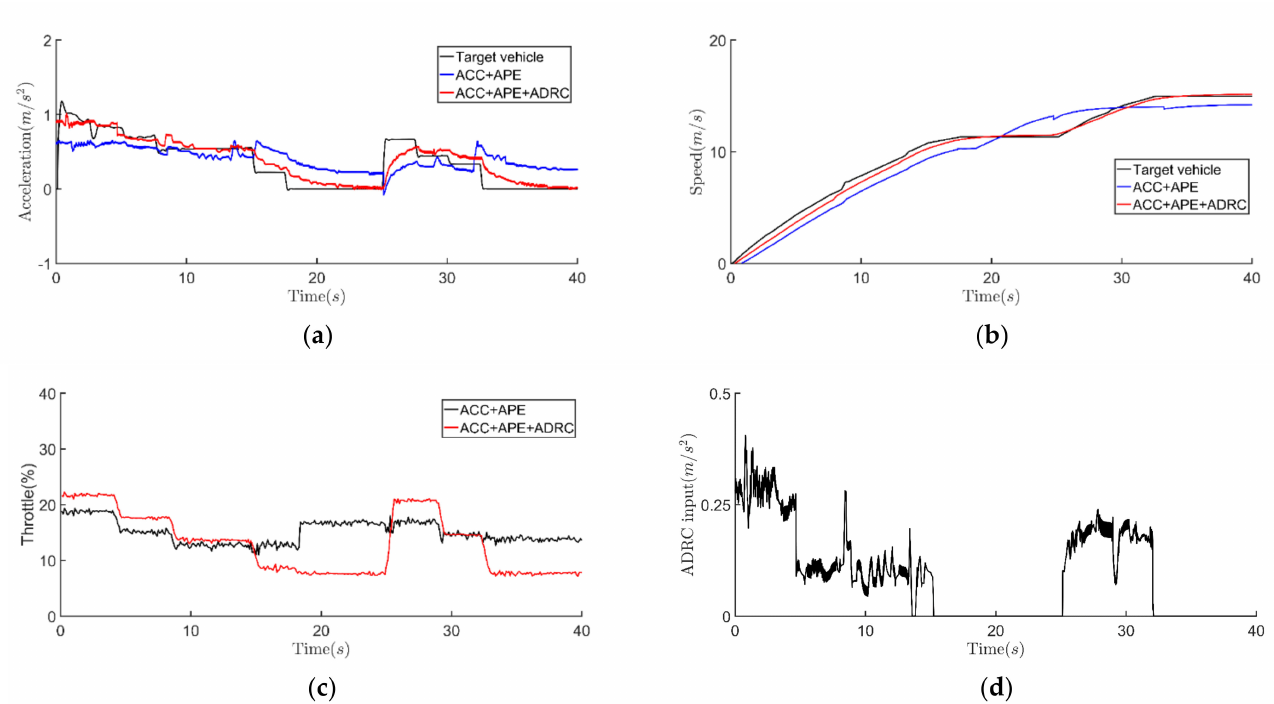
Figure 5. Comparison results for ACC − APE and ACC − APE − ADRC: ( a ) acceleration; ( b ) speed; ( c ) throttle; and ( d ) ADRC input.